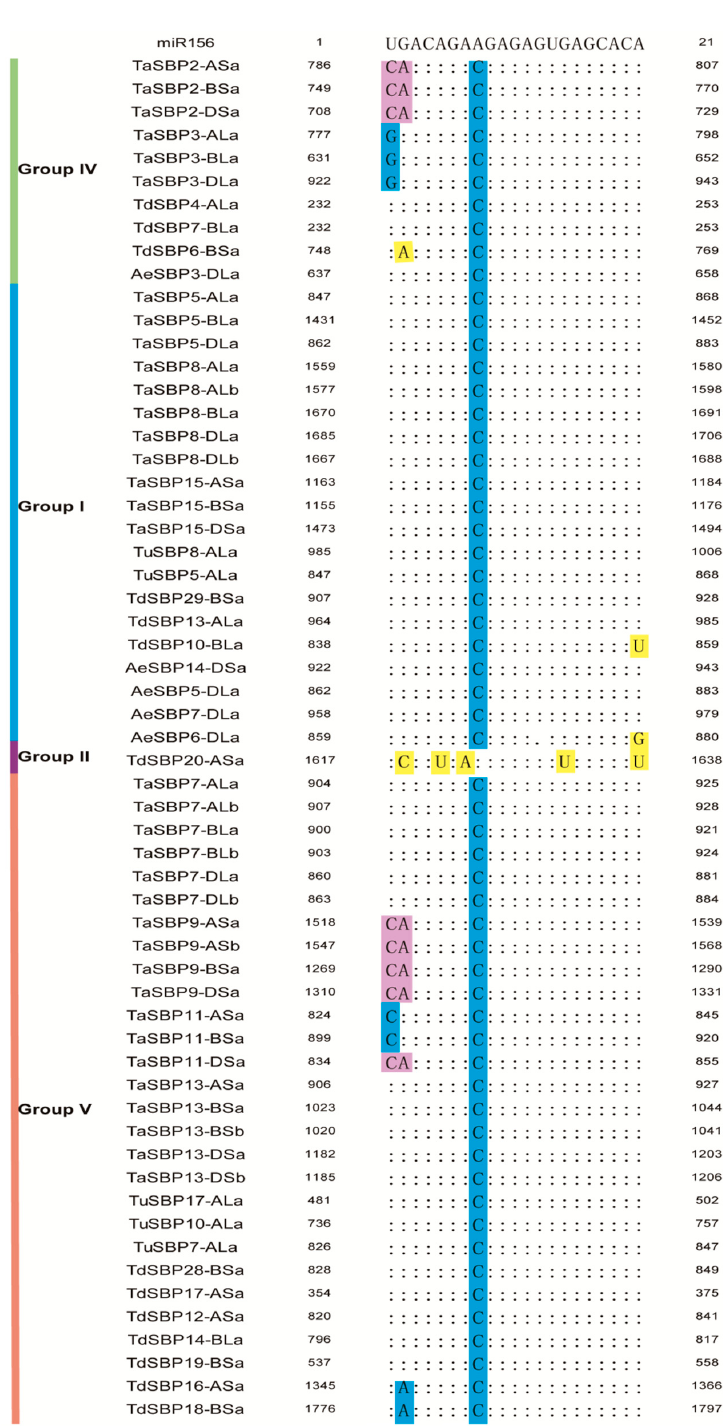
Figure 6. Alignment of putative target areas for miR156. The three mismatched types are represented by blue, yellow, and purple. The colons are areas of complete match.